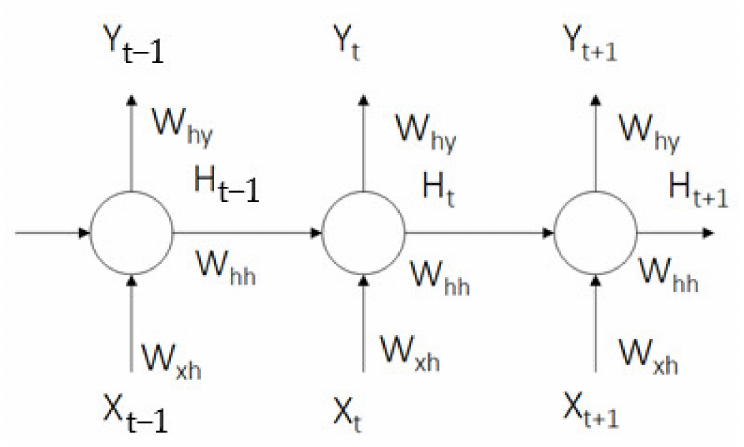
Figure 2. Unfolding recurrent neural